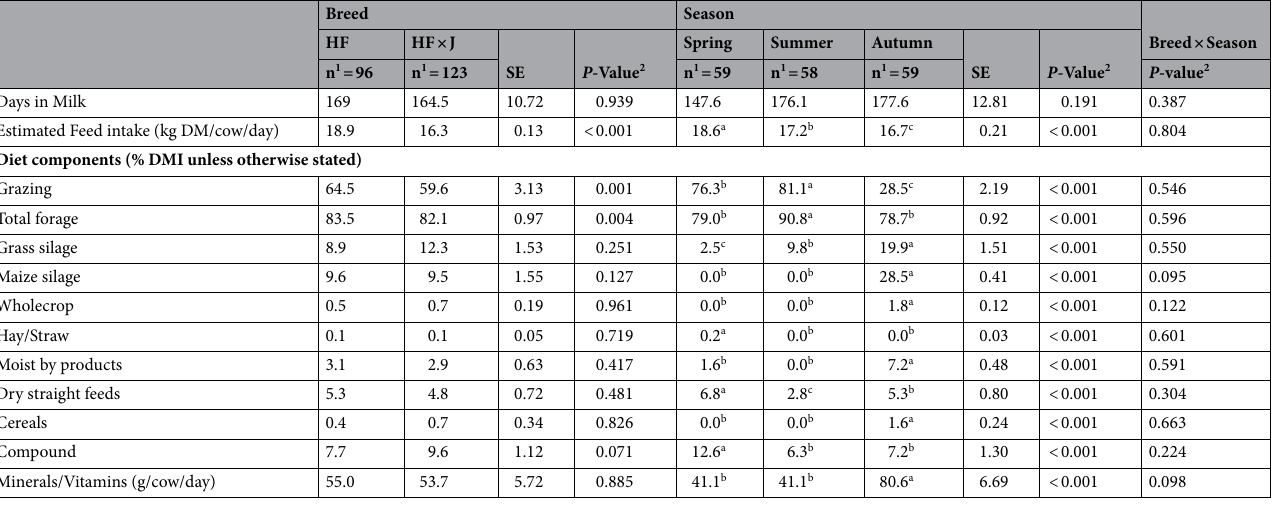
Table 1. Means ± SE and ANOVA P-values for the estimated dry matter (DM) intake (DMI) and dietary components (% of DMI) in 73 individual cows from two breeding groups (100% Holstein-Friesian, HF; 50% Holstein-Friesian:50% Jersey, HF × J) and different seasons in four low-input dairy farms in England and Wales. 1 n is the number of records used to calculate means. 2 Significances were declared at P < 0.05. Means within a row, for season, with different upper-case letters are significantly different according to Fisher’s protected least significant difference test ( P <